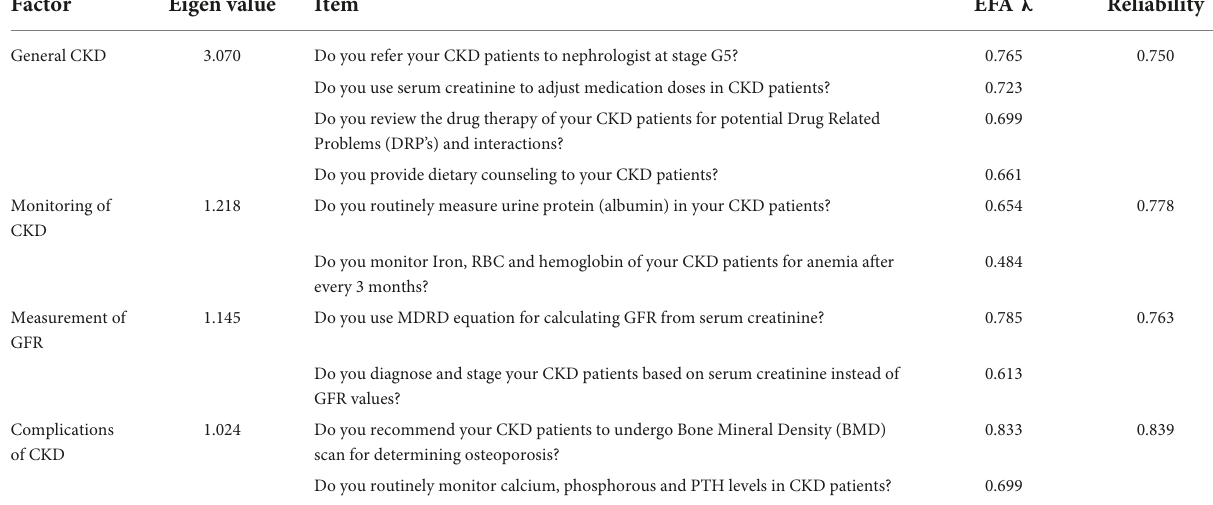
TABLE 6 Results of the EFA analysis in the practices section of the validation